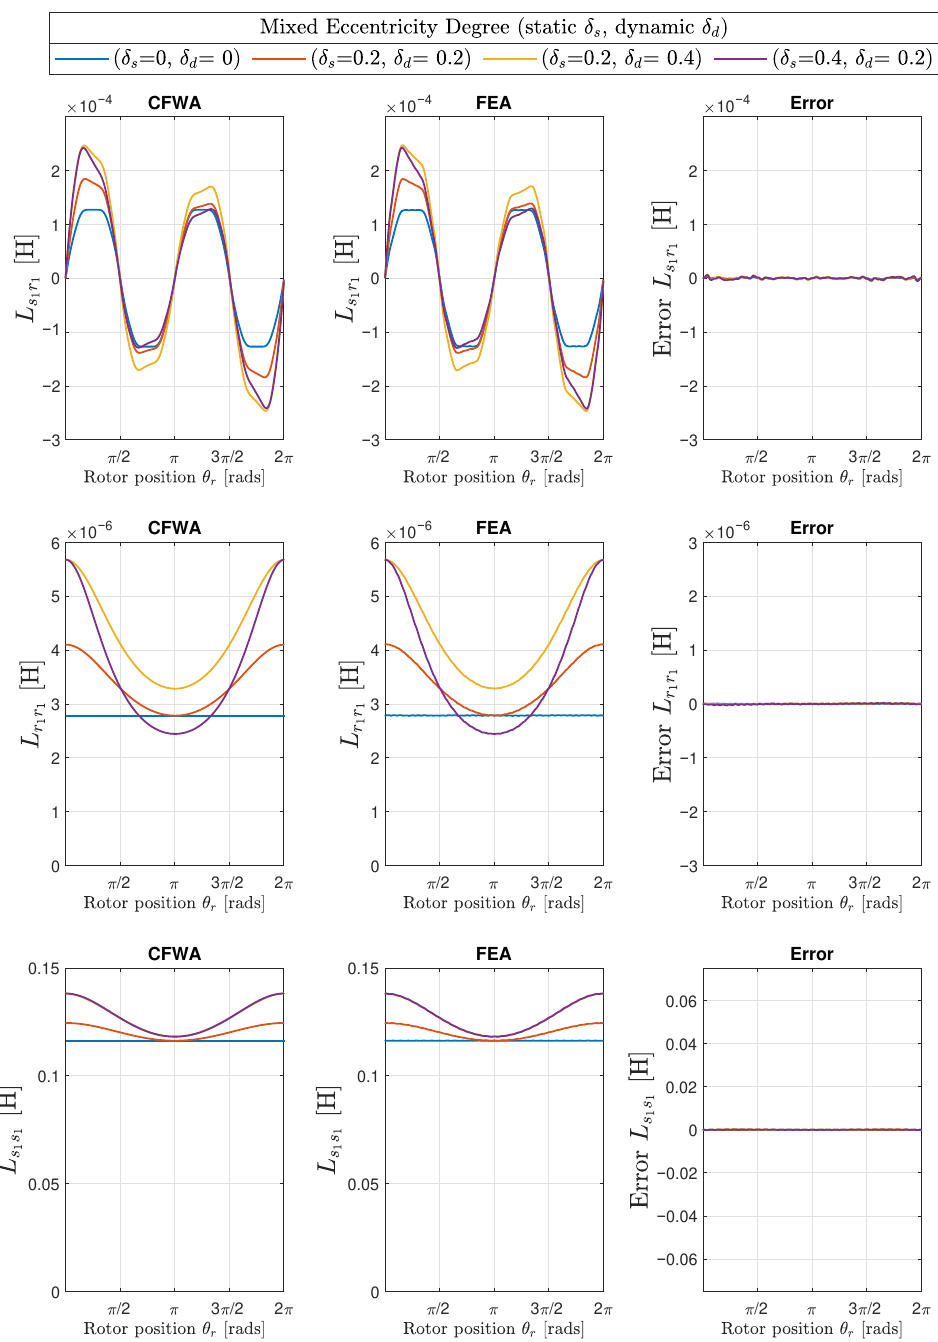
Figure 17. Mutual inductance between the first stator and the first rotor phase ( L s , top row ) 1 r 1 and self-inductances of the first rotor phase ( L r , middle row ) and of the first stator phase ( L s , 1 r 1 1 s 1 bottom row ), for the IM of Appendix A, with three different degrees of static ( δ s ) and dynamic ( δ d ) eccentricity: ( δ s = 0.2, δ d = 0.2), ( δ s = 0.2, δ d = 0.4), and ( δ s = 0.4, δ d = 0.2). The case of healthy machine ( δ s = 0.0, δ d = 0.0) has also been included for comparative purposes. The first column presents the results obtained with the conformal winding tensor approach, the second column contains the results obtained with FEA, and the third column contains the errors between both